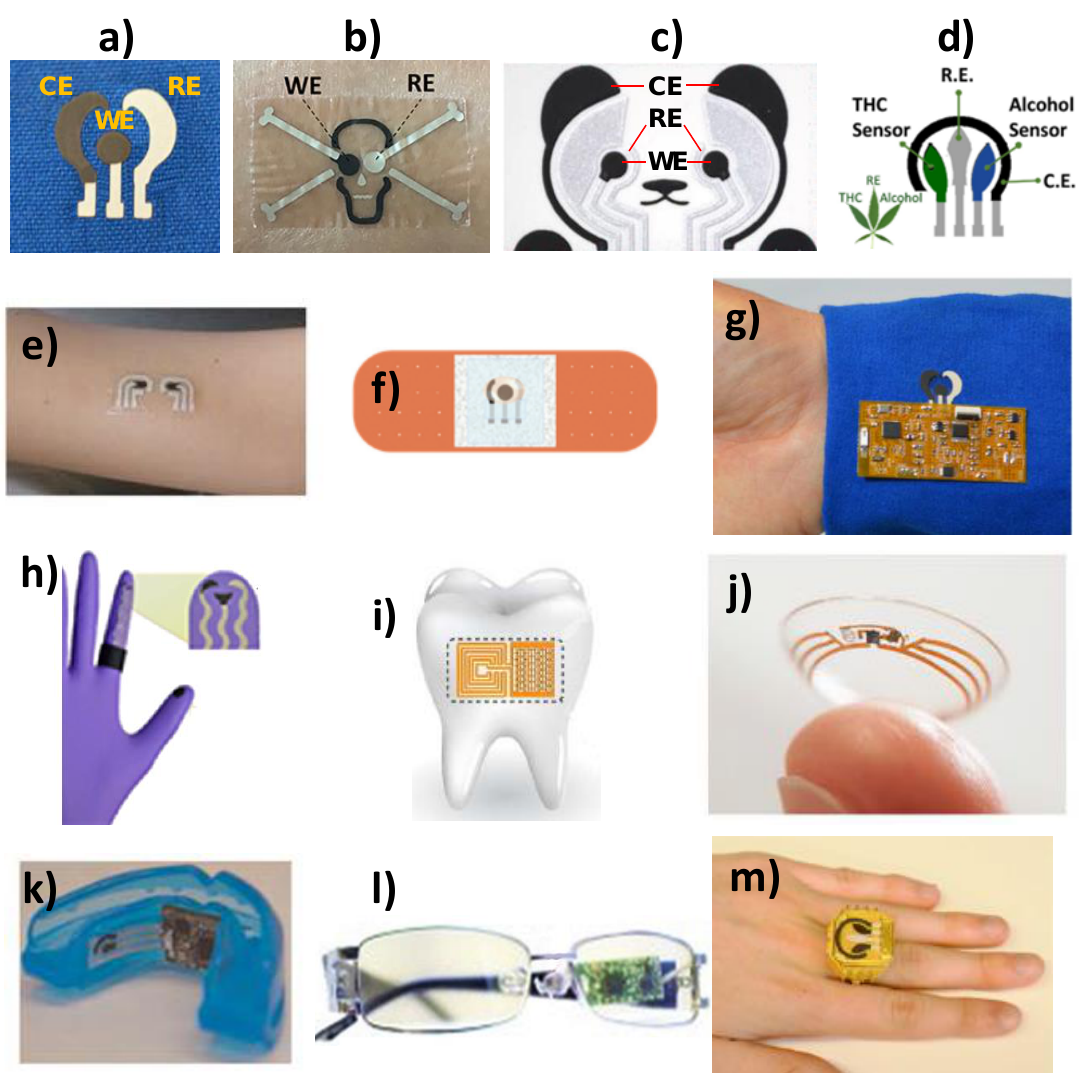
Figure 7. SPEs printed on flower ( a ), skull ( b ), panda bear ( c ), and marijuana ( d ) shapes. SPEs fabricated on a temporary tattoo ( e ), bendable bandage ( f ), textile substrate ( g ), glove ( h ), water-soluble silk thin-film substrates (transferred to tooth enamel) ( i ), contact lens ( j ), or incorporated in a mouthguard ( k ), eyeglasess ( l ) or ring ( m ). Reprinted and adapted with permission of Springer [68] ( e , j , k ) Wiley [81] ( f ), Elsevier [82] ( a , g ), Elsevier [82]( b ), Wiley [83] ( c ), Wiley [65] ( h ), Nature Research [84] ( i ), Elsevier [85] ( l ), and Elsevier [86] ( c , m ).